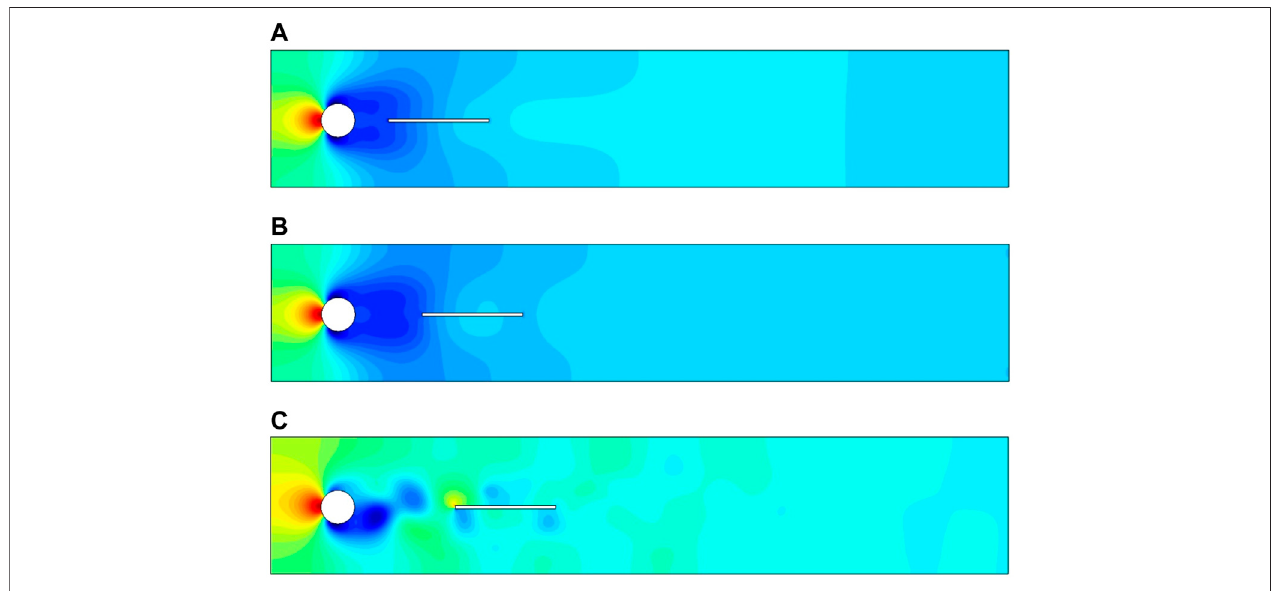
FIGURE 8 | In fl uence of detached splitter plate (length L (cid:1) 0 . 3 ) on velocity, placed at gaps (A) G 1 = 0.1 , (B) G 2 = 0.2 , (C) G 3 = 0.3 with Re (cid:1) 100 at (cid:2) t (cid:1) 10 .